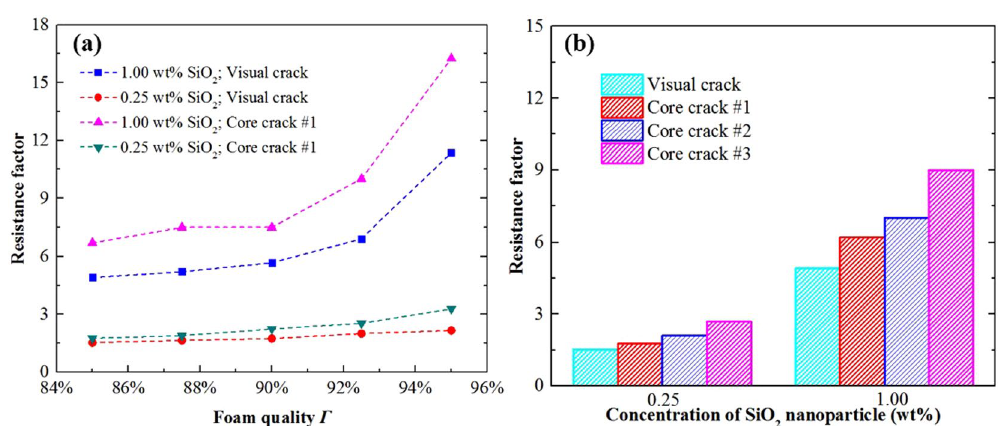
Figure 13. ( a ) Foam resistance factor in visual and core cracks vs foam quality. ( b ) Foam resistance factors for visual and core cracks with different surface roughness. Foam quality 85%, surface roughness of core cracks increased from 1 to 3 and is included in Table 1. SDBS concentration was kept at 0.1 wt%, foam flow velocity ν in cracks was kept at 5